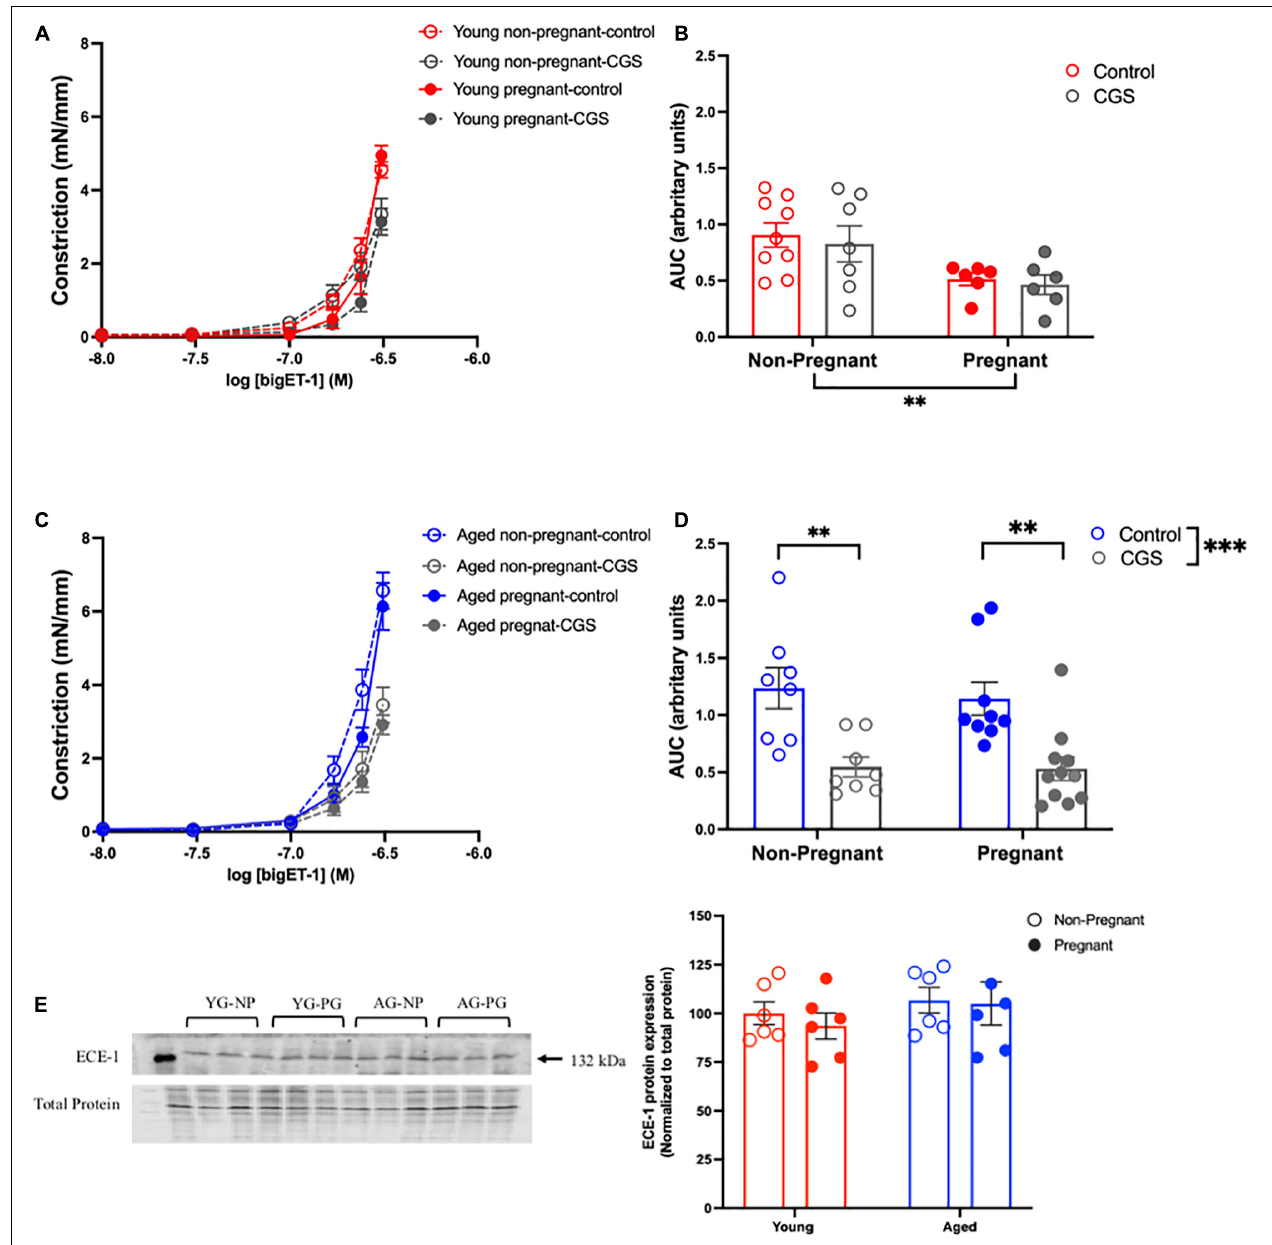
FIGURE 8 | Increased contribution of endothelin converting enzyme (ECE) in converting bigET-1 in aged non-pregnant and pregnant rats. (A,C) Vascular contraction response to bigET-1 in the presence or absence of ECE-1 inhibitor CGS35066 (CGS) in mesenteric arteries of young [3–4 months; in red; (A,B) ] and aged [9–9.5 months; in blue; (C,D) ] pregnant (on gestational day 20; closed circles) and non-pregnant (age-matched; open circles) rats. (B,D) Data summaries of area under the curve (AUC) of the bigET-1 responses. (E) Western blot analysis of ECE-1 protein normalized to total protein in mesenteric arteries; the ECE-1 data is expressed as percentage of control (the mean of the non-pregnant young group). Data are presented as mean ± SEM; analyzed by two-way ANOVA with Sidak’s multiple comparisons post hoc test; ∗∗ p < 0.001; ∗∗∗ p < 0.001; n = 6–8/group. YG-NP, young non-pregnant; YG-PG, young pregnant; AG-NP, aged non-pregnant; AG-PG, aged